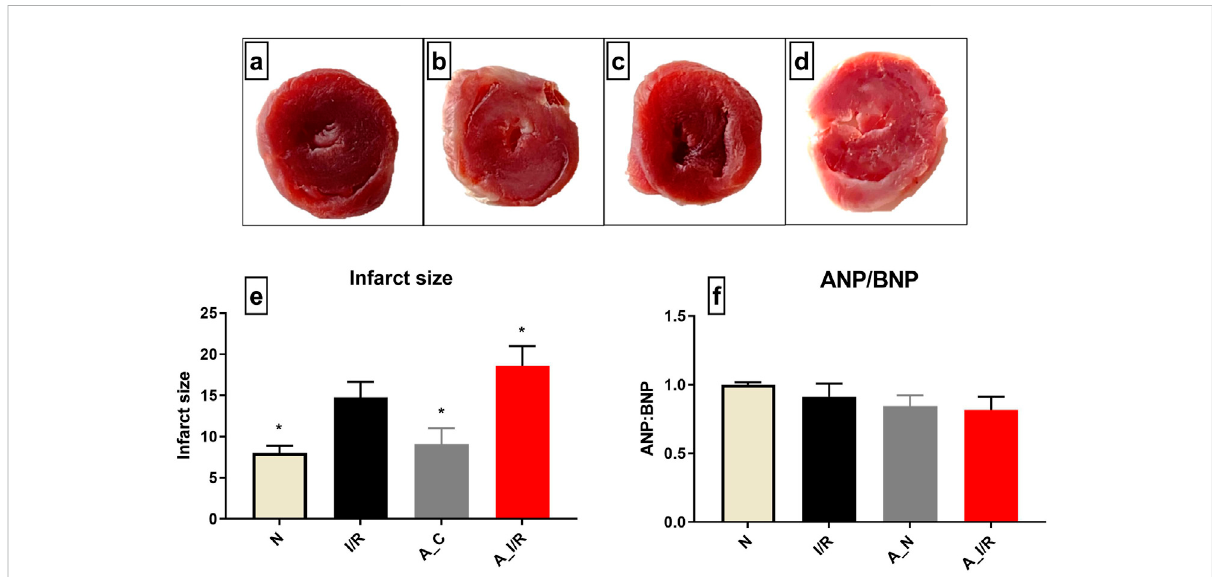
FIGURE 1 Cardiac I/R injury assessment in young and adult rat hearts: The representative TTC stained images of isolated rat hearts subjected to the perfusion protocol as per the groups: (A) N, (B) I/R, (C) A_N, (D) A_I/R. (E) represents the percentage of infarct size. The representative images were obtained at ×10 magni fi cation. (F) represents the ANP/BNP ratio. The graph represents the mean ± SEM. *p < 0.05 vs. I/R